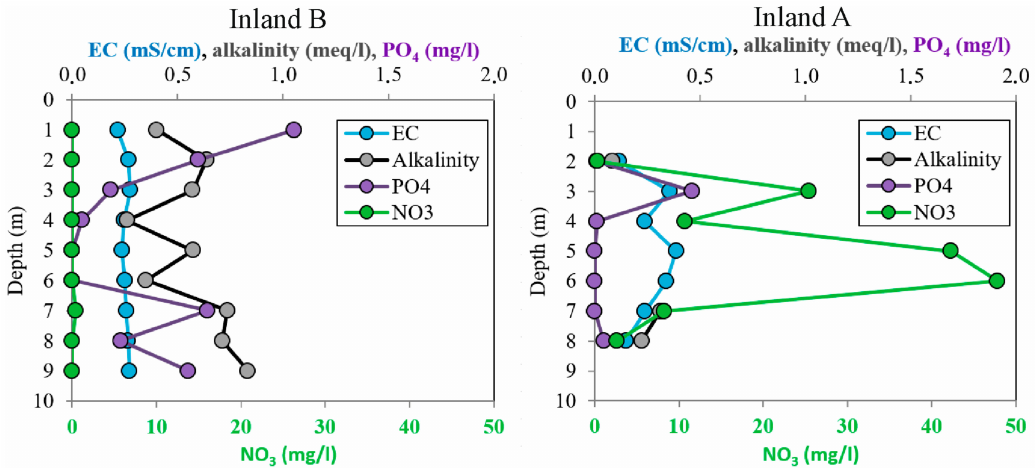
Figure 7. Profiles of measured EC, alkalinity, PO 4 , and NO 3 for Inland wells A and B.